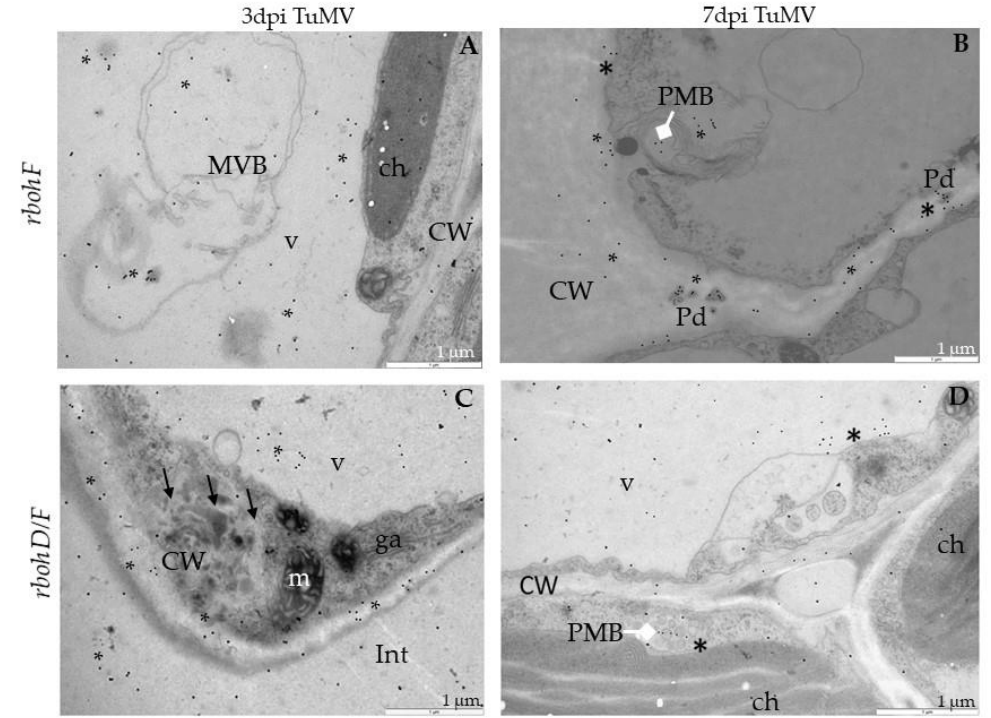
Figure 10. Localization of PR1 in rbohF and rbohD / F leaf tissues 3 ( A , C ) and 7 days ( B , D ) after TuMV inoculation examined by immunogold electron microscopy. ( A ) PR1 localization (*) around multivesicular bodies (MVBs) in vacuole (v) in rbohF palisade mesophyll cell. ch—chloroplast; CW—cell wall. ( B ) PR1 presence (*) in plasmodesmata (Pd), cell wall (CW) and paramular bodies (PMBs; white diamond head arrow) in rbohF phloem parenchyma cell. ( C ) PR1 (*) in and around changed (arrows) cell wall (CW) in rbohD / F spongy mesophyll cell. ga—Golgi apparatus, m—mitochondrion, v—vacuole. ( D ) PR1 presence (*) in paramular bodies (PMBs; diamond head arrow) and vacuole (V) in rbohD / F spongy mesophyll cell. ch—chloroplast; CW—cell wall; v—vacuole.